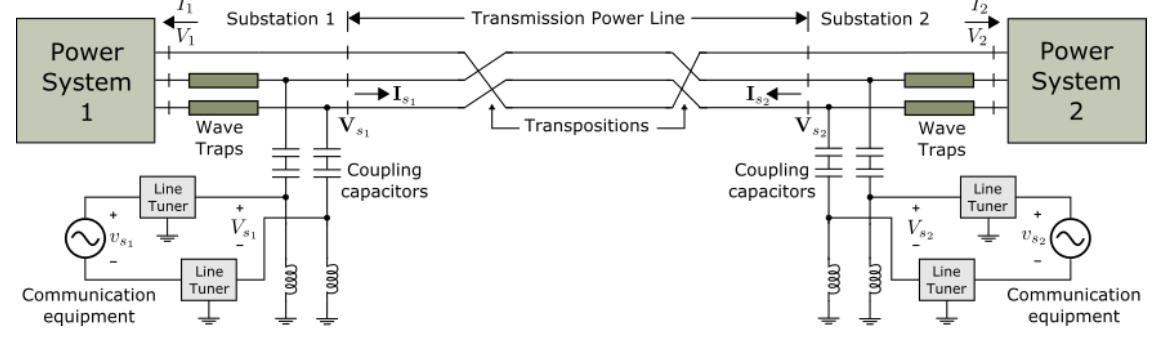
Figure 1. Diagram of an HV-PLC